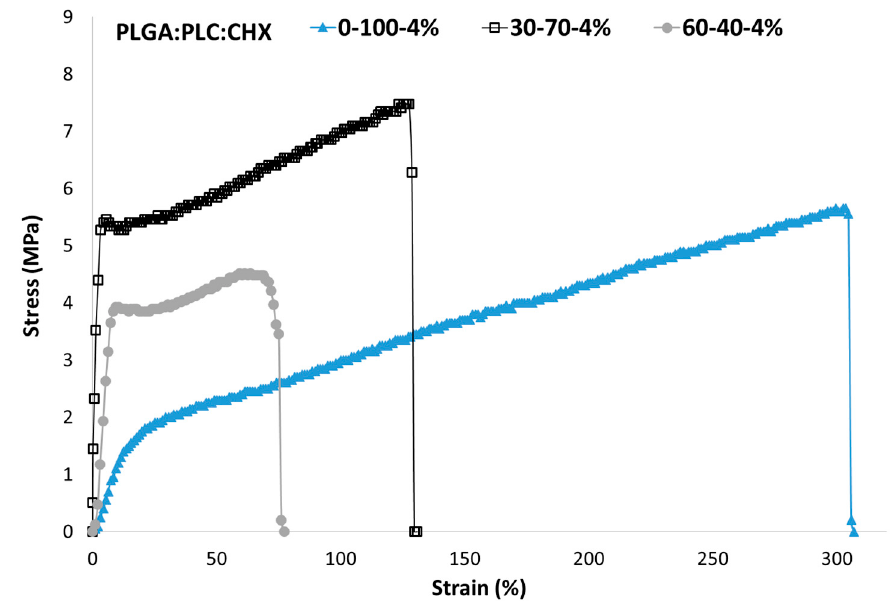
Figure 9. Stress–strain curve according to the ratio between PLGA and PLC copolymers for a CHX loading of 4%.